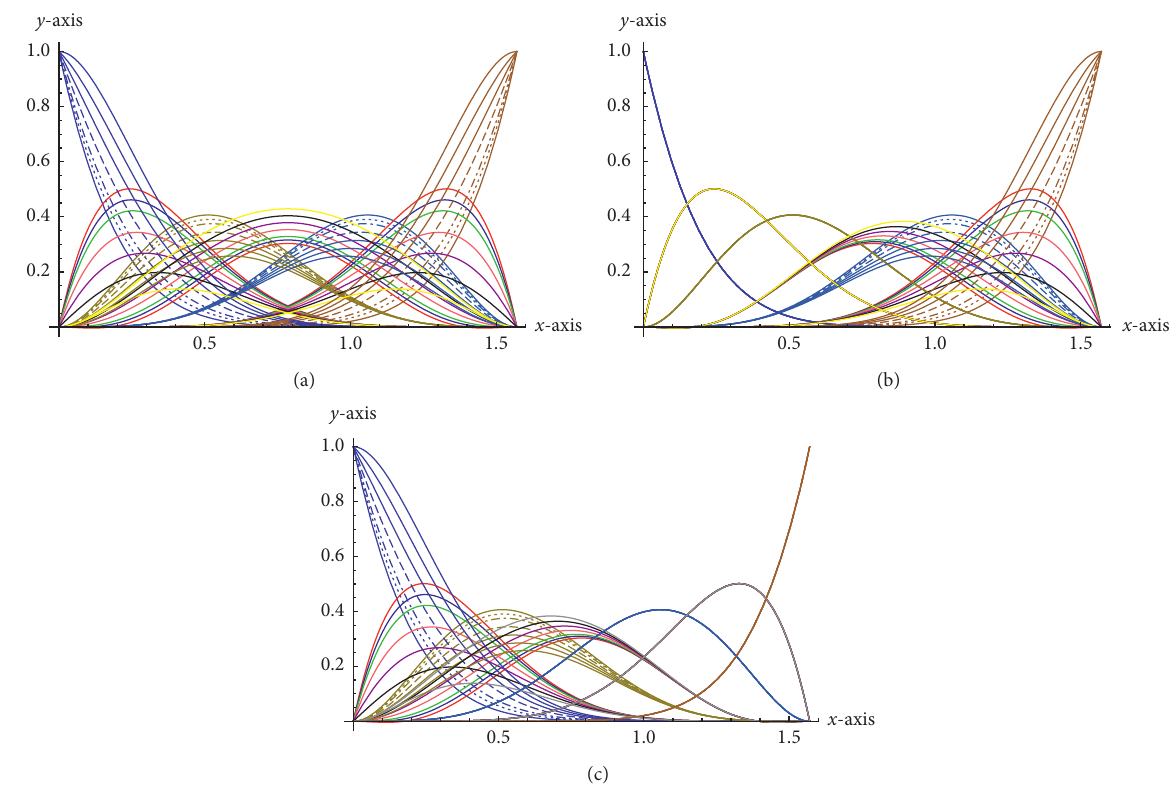
Figure 1: ST-Bernstein basis functions with shape